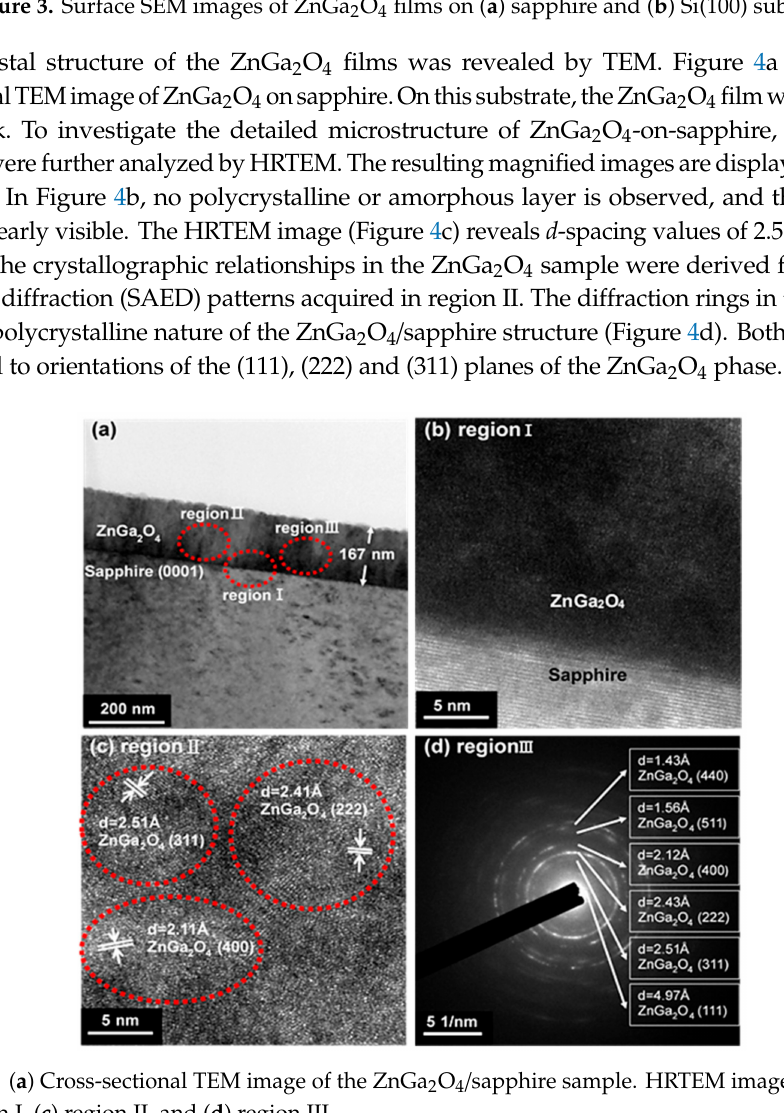
Figure 3. Surface SEM images of ZnGa 2 O 4 films on ( a ) sapphire and ( b ) Si(100) substrates.